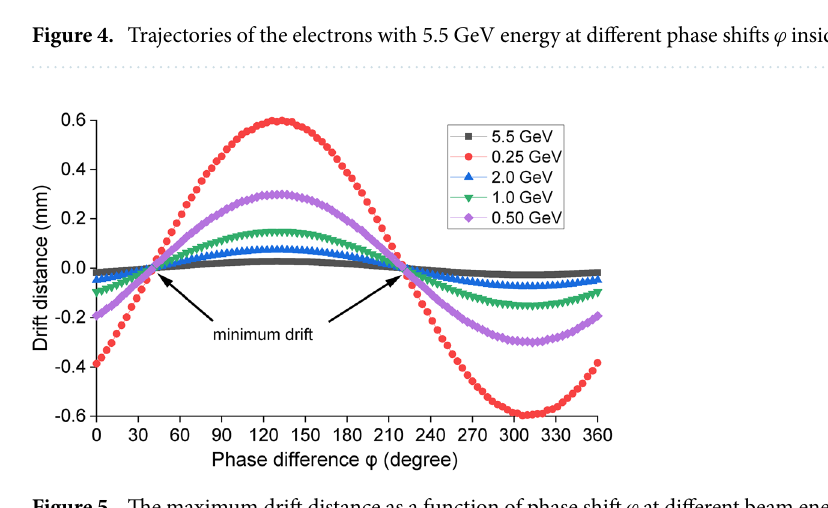
Figure 5. The maximum drift distance as a function of phase shift ϕ at different beam